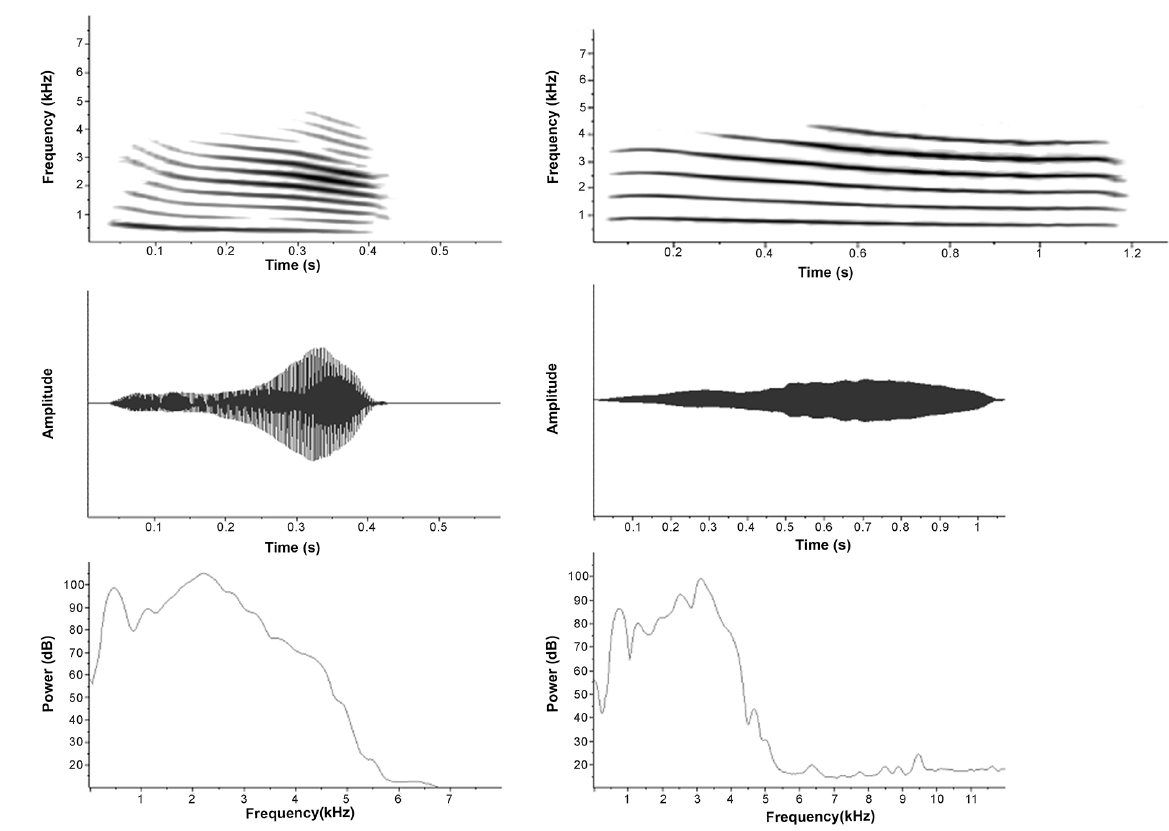
Figure 4. Power spectrum of the first third (left) and the final third (right) of an advertisement call of P. aff. albonotatus (above) and P. santafecinus